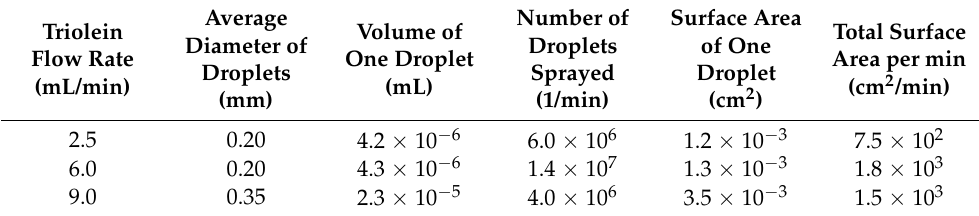
Table 1. Average diameters and surface areas of sprayed droplets.